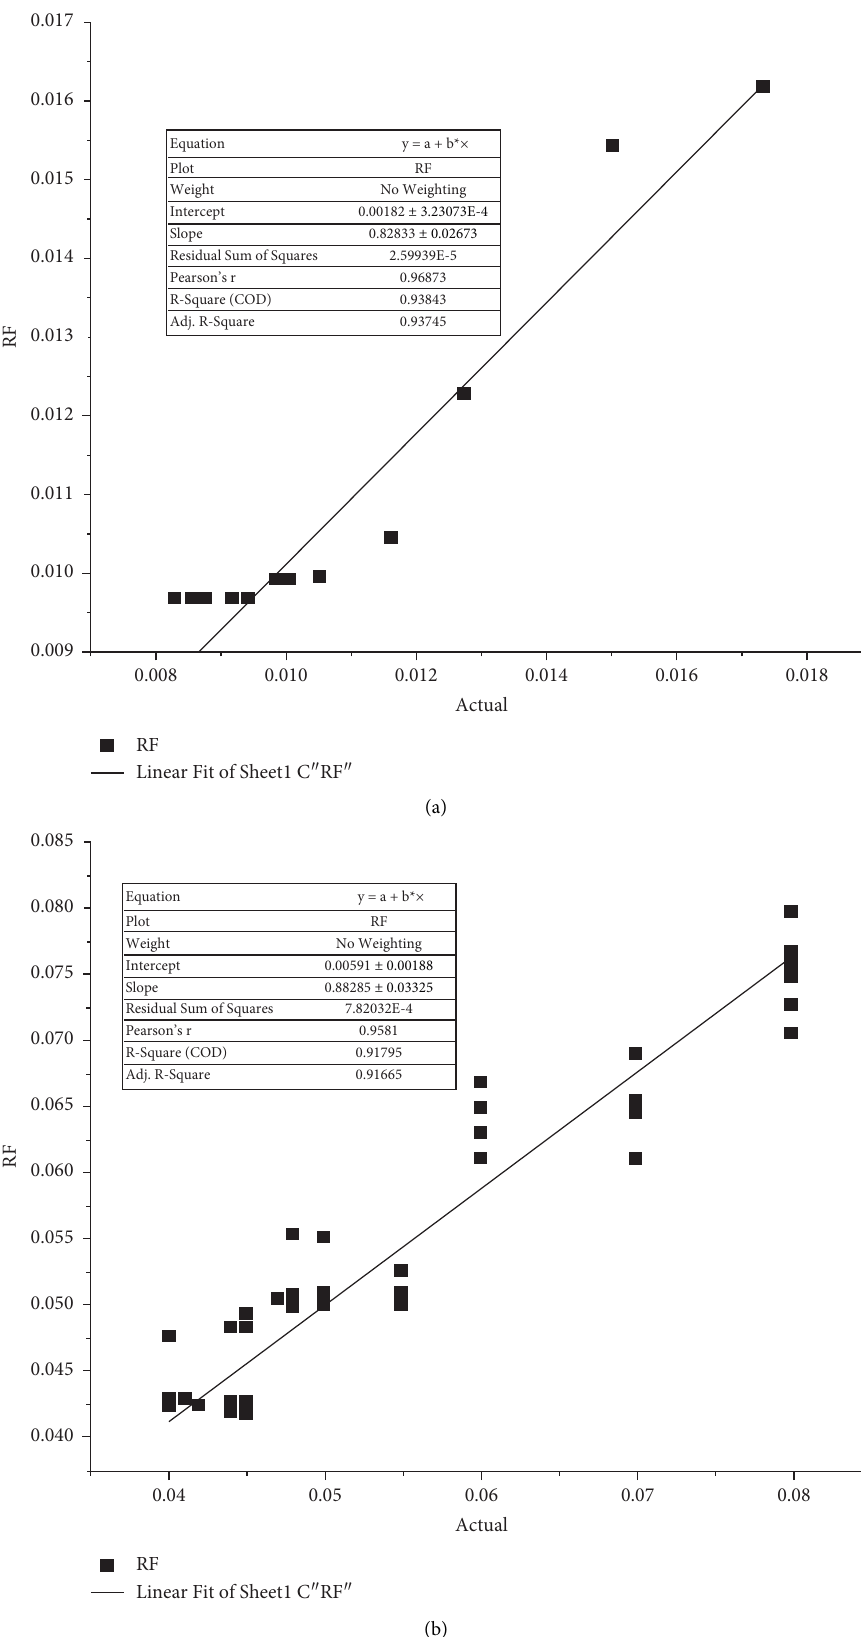
Figure 5: Te random forest model scatter plots for the testing phase of the gas fow: (a) fracture porosity in oil system and (b) fracture